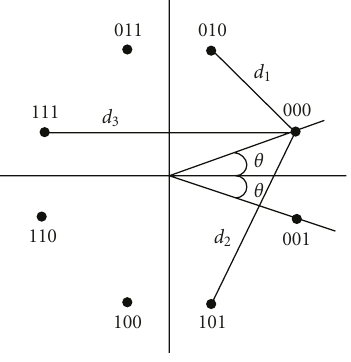
Figure 3: Euclidean distances for the nonuniform 8-PSK constella-